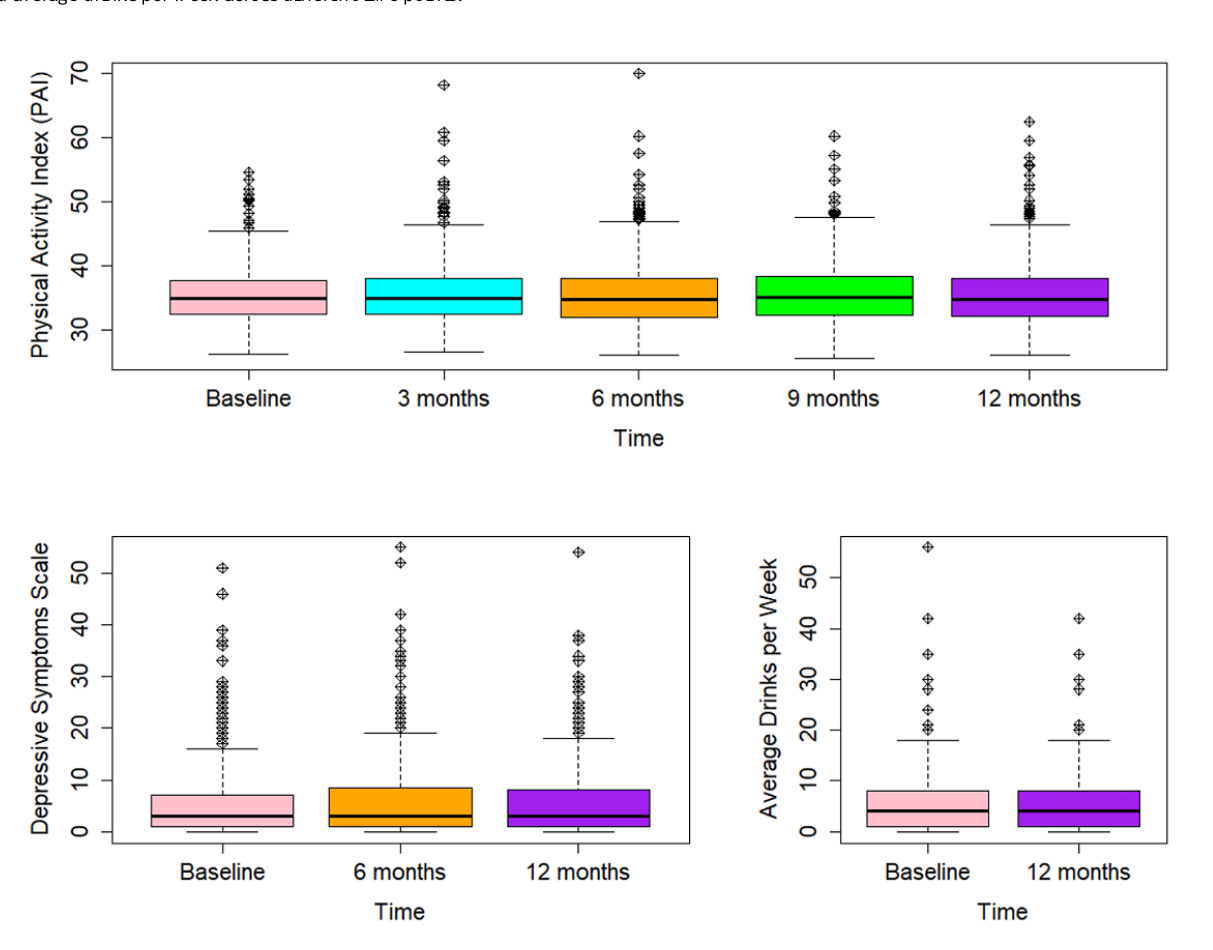
Figure 4. Boxplots for Physical Activity Index (PAI), depressive symptoms scale (Center For Epidemiologic-Studies Depression Scale [CES-D] score), and average drinks per week across different time